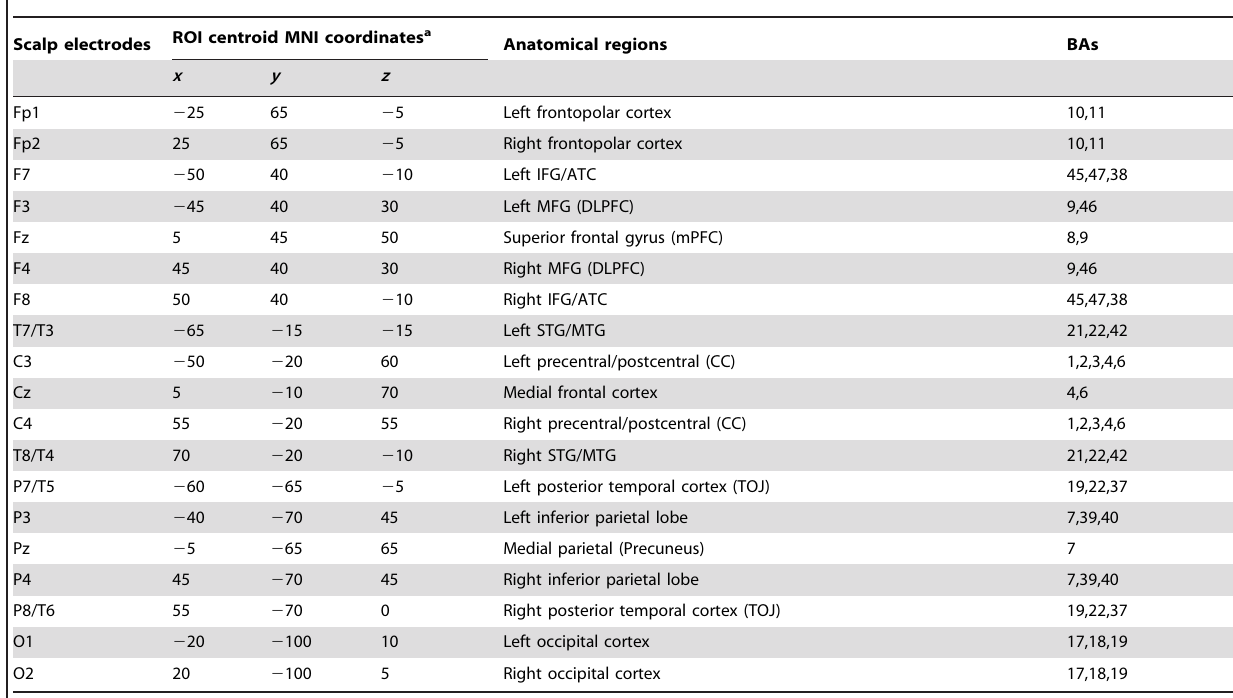
Table 2. Cortical regions of interest (ROIs) determined by eLORETA.